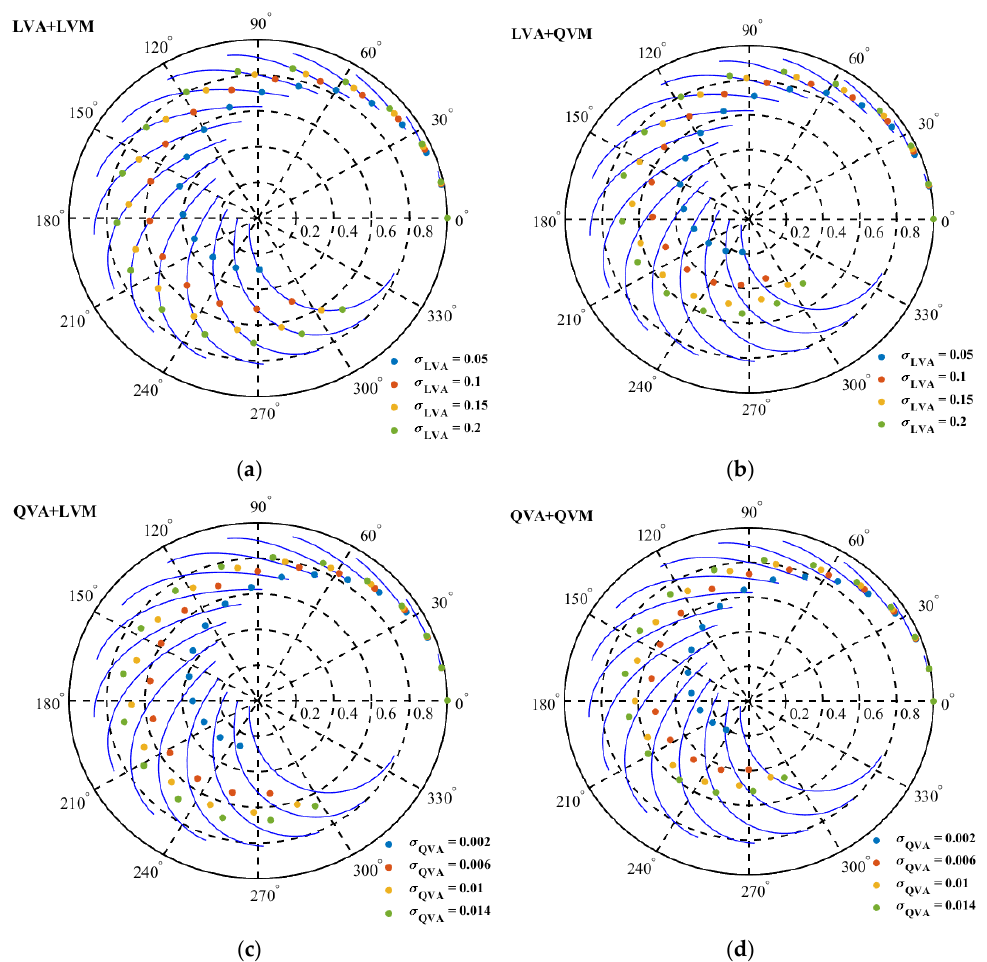
Figure 5. Volumetric-temporal coherence varying with different extinction coefficients: ( a ) LVA + Volumetric-temporal coherence varying with different extinction LVM; ( b ) LVA + QVM; ( c ) QVA + LVM; ( d ) QVA + QVM.